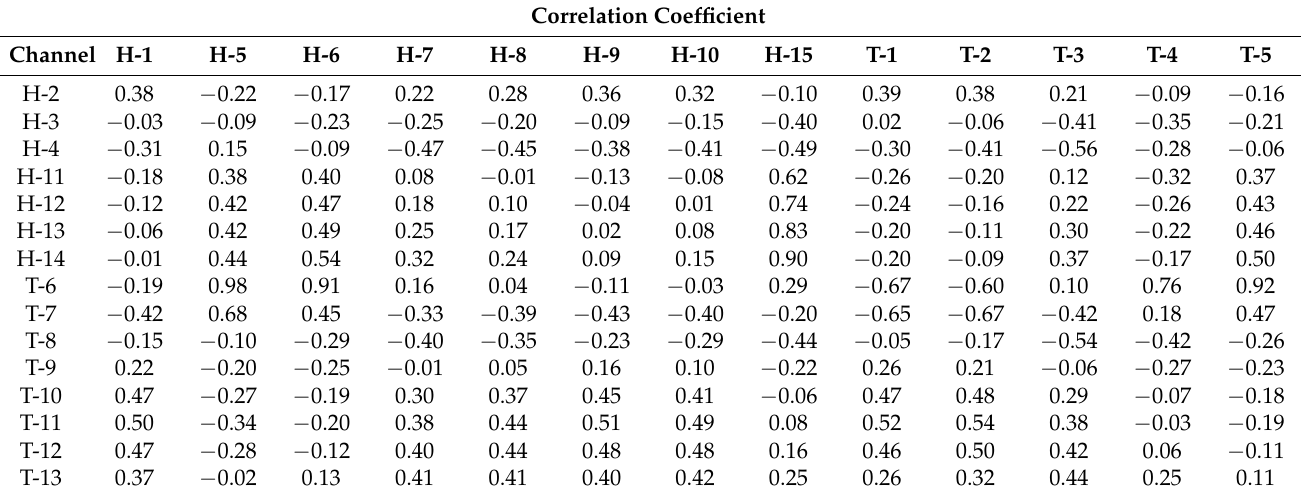
Table 3. The correlation coefficients between observations of the channels with zero Y ( P S ,0 ) and observations of the channels with non-zero Y ( P S ,0 ) for MWHTS and